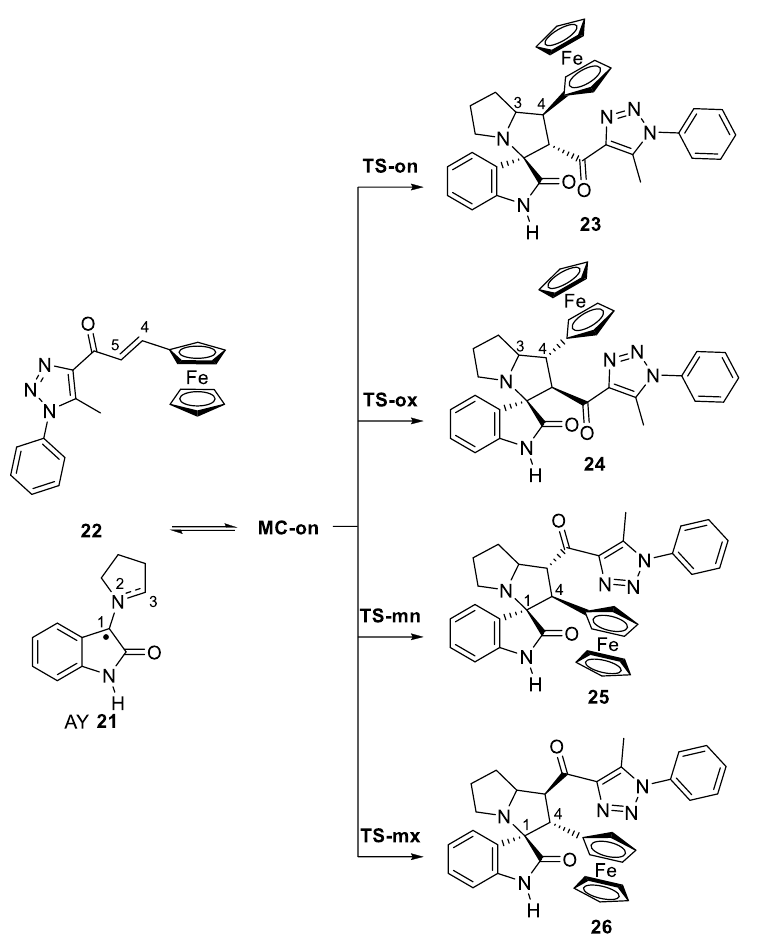
Scheme 5. Competitive reaction paths associated with the 32CA reaction of AY 21 and ferrocene ethylene 22 . Table 2. ω B97X-D/6-311G(d,p) relative energies, in kcal · mol − 1 , in gas phase and in methanol, of the stationary points involved in the 32CA reaction of AY 21 with ferrocene ethylene 22